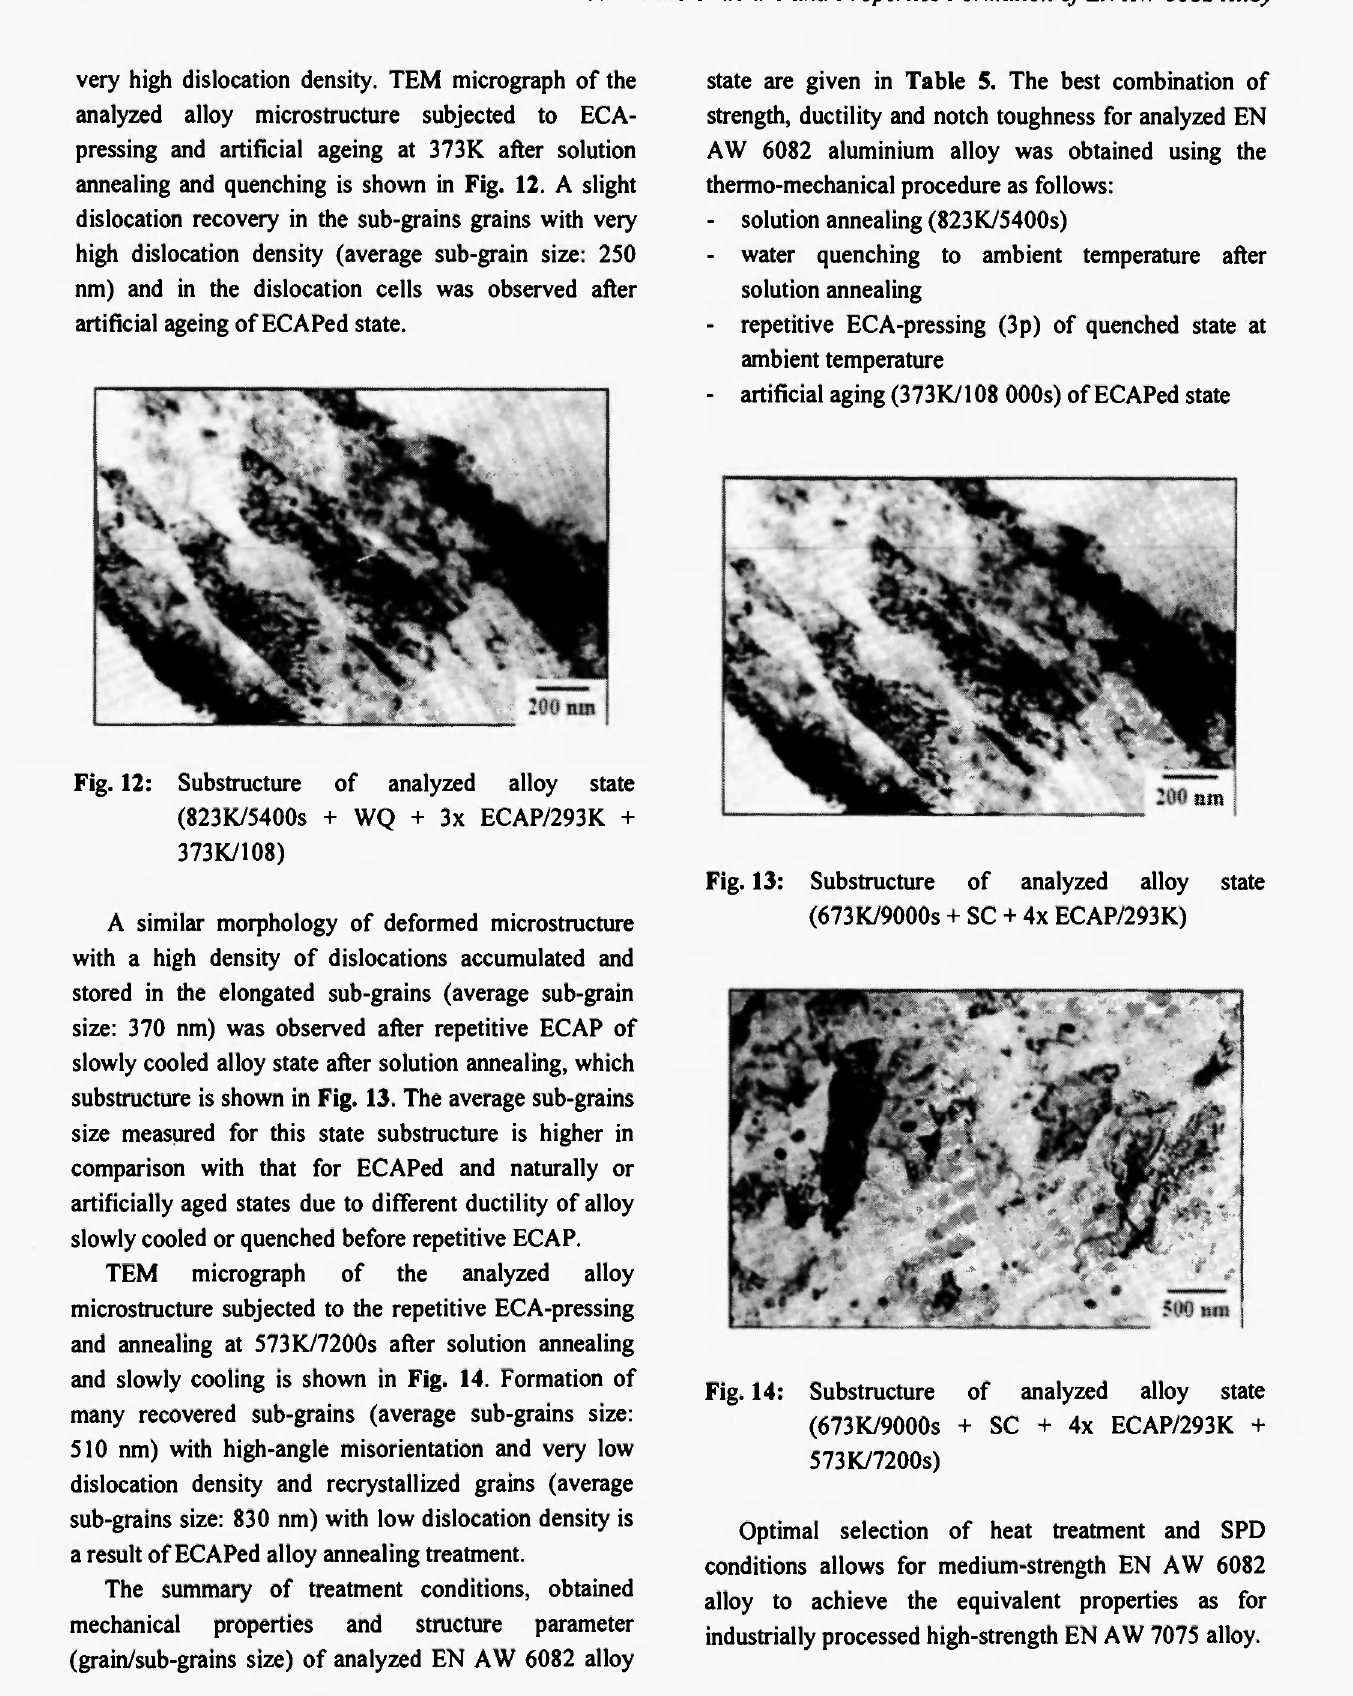
Fig. 12: Substructure of analyzed alloy state (823K/5400s + WQ + 3x ECAP/293K + 373K/108)